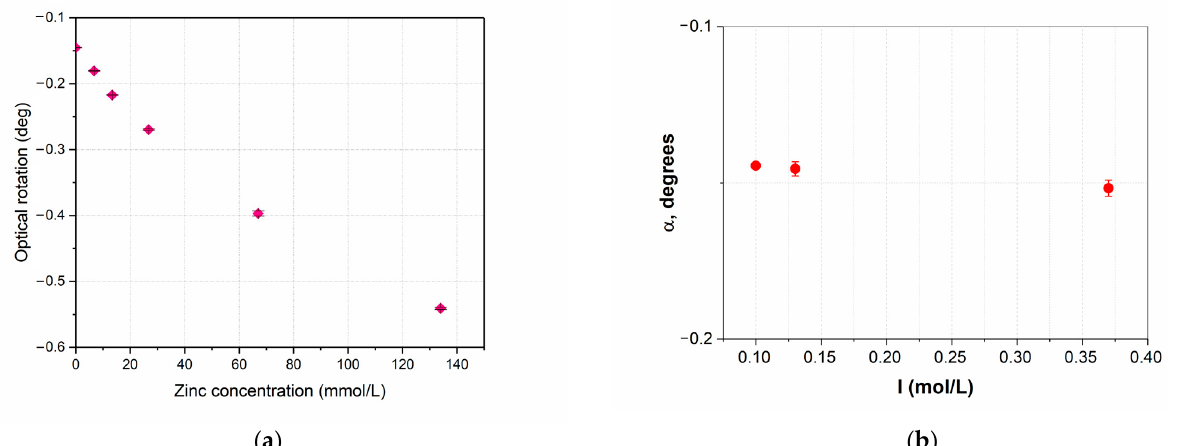
Figure 8. Optical activity of methionine and zinc sulfate solutions during the complexation reaction at pH 5.74 under conditions of increasing concentration of the complexing agent. The error bars represent the standard deviation of measurements (n = 5) ( a ). Control of ionic strength influence on the optical activity of methionine solution (134 mmol/L) without added zinc ( b